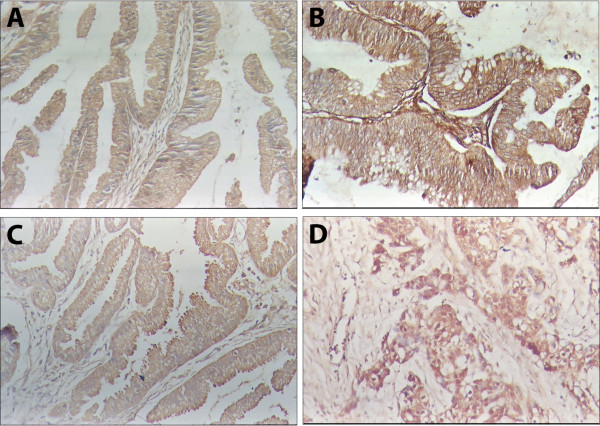
Expression of MK1 and RegIV in the benign and malignant lesions of gallbladder. EnVision immunohistochemistry, original magnification x200. MK1 and RegIV positive reaction was mainly localized in the cell membrance and/or cytoplasm. A, MK1 positive expression in peri-tumor tissue with moderate atypical hyperplasia. B, MK1 positive expression in highly differentiated gall bladder adenocarcinoma. C, RegIV positive expression in polyp with severe atypical hyperplasia. D, RegIV positive expression in moderately differentiated gall bladder adenocarcinoma.